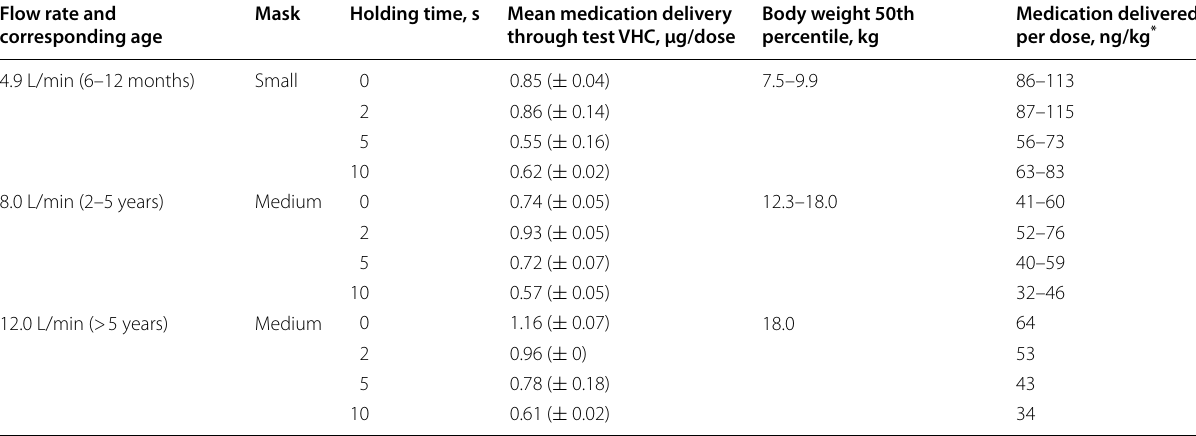
Table 1 In vitro medication delivery through the test VHC with small/medium face masks at different flow rates and hold‑ ing